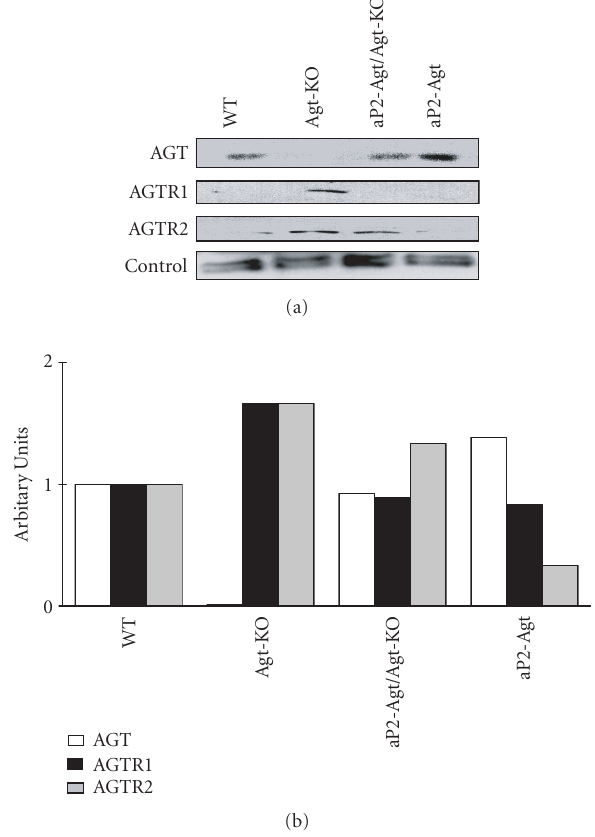
Figure 1: Expression of RAS proteins in adipose tissue of WT, Agt -KO, aP2- Agt / Agt -KO, and aP2- Agt mice. Representative im- munoblots of AGT, AGTR1, and AGTR2 proteins are shown. A 95 kD protein is included as an internal loading control. The bar graph represents average expression of RAS proteins from two West- ern blots for two di ff erent experiments ( n =